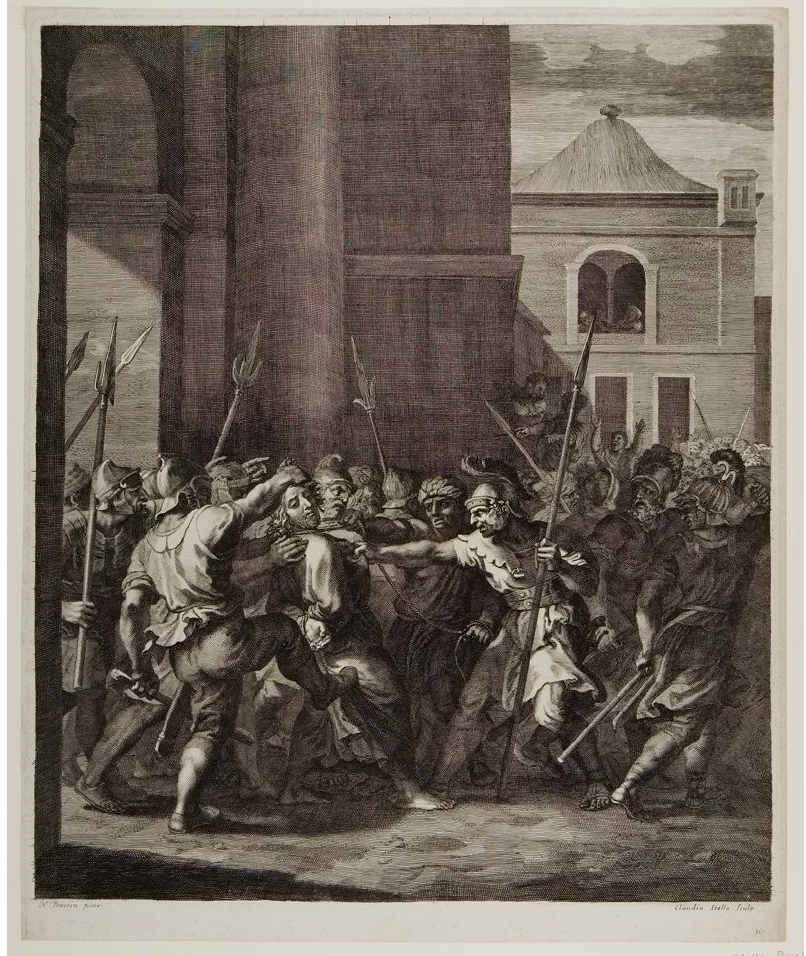
Figure 8. Claudine Bouzonnet-Stella. Christ Conducted from Caiaphas to Pilate , before 1697.